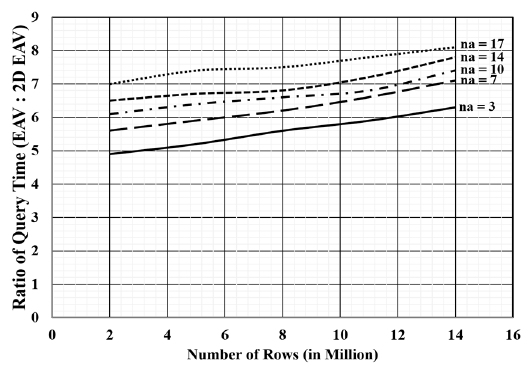
Figure 8. Projection operation results.